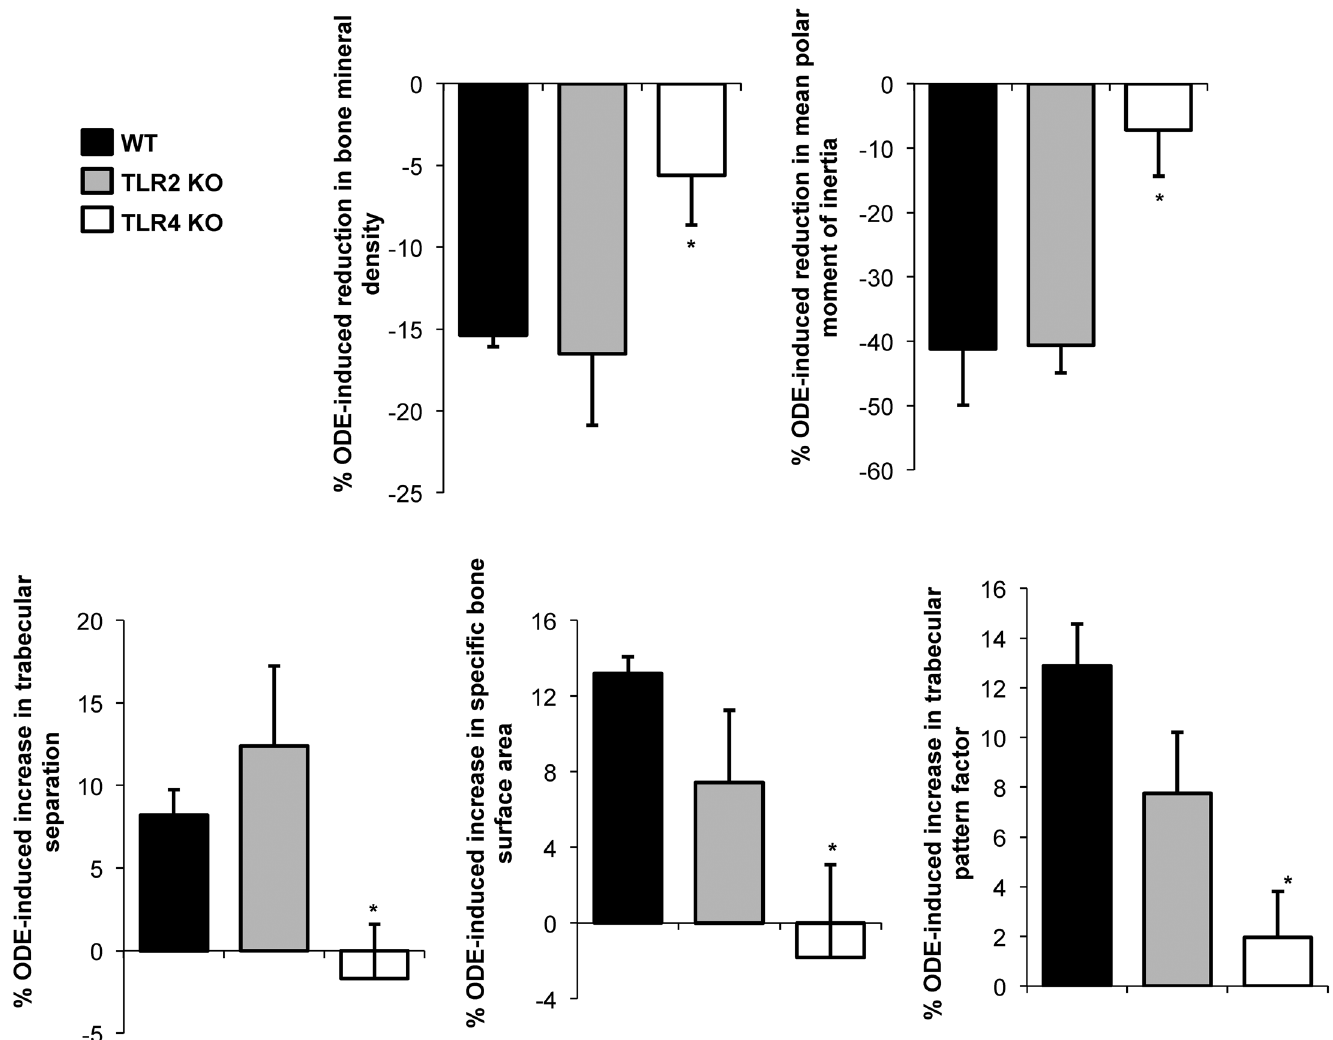
Fig 5. WT and TLR2 KO, but not TLR4 KO, mice were susceptible to the systemic bone deterioration response following repetitive ODE inhalation exposure by micro-CT analysis. WT, TLR4 KO, and TLR2 KO mice were i . n . treated daily with saline or ODE for 3 weeks whereupon trabecular bone of proximal tibia was analyzed micro-CT analysis. Changes in bone quality and bone quantity were observed in ODE-treated WT mice as compared to saline. TLR4 KO, but not TLR2 KO, animals were generally less responsiveness to bone changes induced by ODE. To compare findings across animal strains, bar graph depicts the mean with SEM bars of the percent change induced by ODE treatments (difference between ODE and saline treatment divided by saline groups multiplied by 100) in bone parameters compiled from three independent studies of 2 – 3 mice per study (N = 6 – 9 mice). Asterisks denote statistical significance ( * p < 0.05) vs.